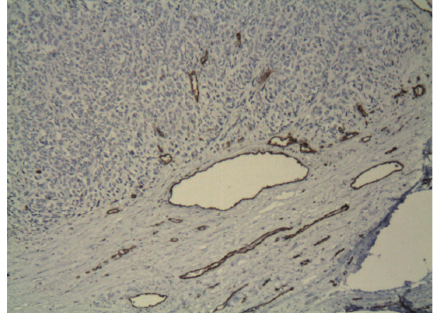
Figure 9: Patient N. aged 57 years, low MVD in the tumor and high MVD in the PA; died within 2 years after surgical